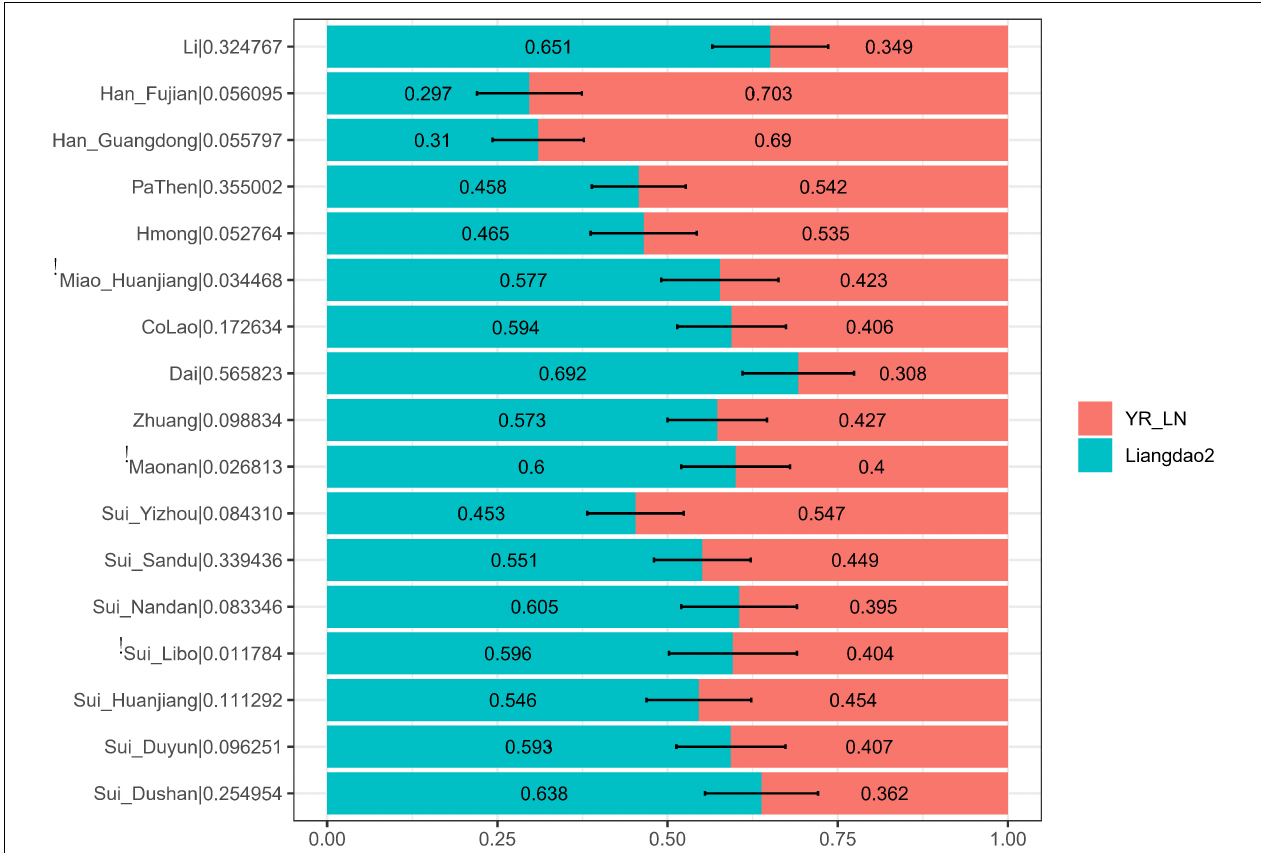
FIGURE 8 | Ancestry mixture coefficients in the two-way admixture model via qpAdm. We used Liangdao2, YR_LN as proxies for ancient Southerneast Asian, ancient North East Asian, respectively. Mbuti, Tianyuan, Papuan, Onge, DevilsCave_N, Japan_Jomon, Mongolia_N_East were used as outgroups. For each target population, we reported the p -value for rank = 1 behind the corresponding population name in the form of “target name| p -value.” The population failed in qpAdm modeling (i.e., p -value < 0.05 for rank = 1) was noted as “!”. Error bar denoted the standard error estimated using jackknife.